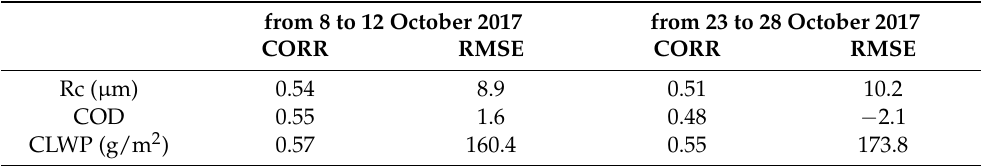
Table 3. Comparison of observed and simulated average Rc, COD and CLWP with CCN values of 250 cm − 3